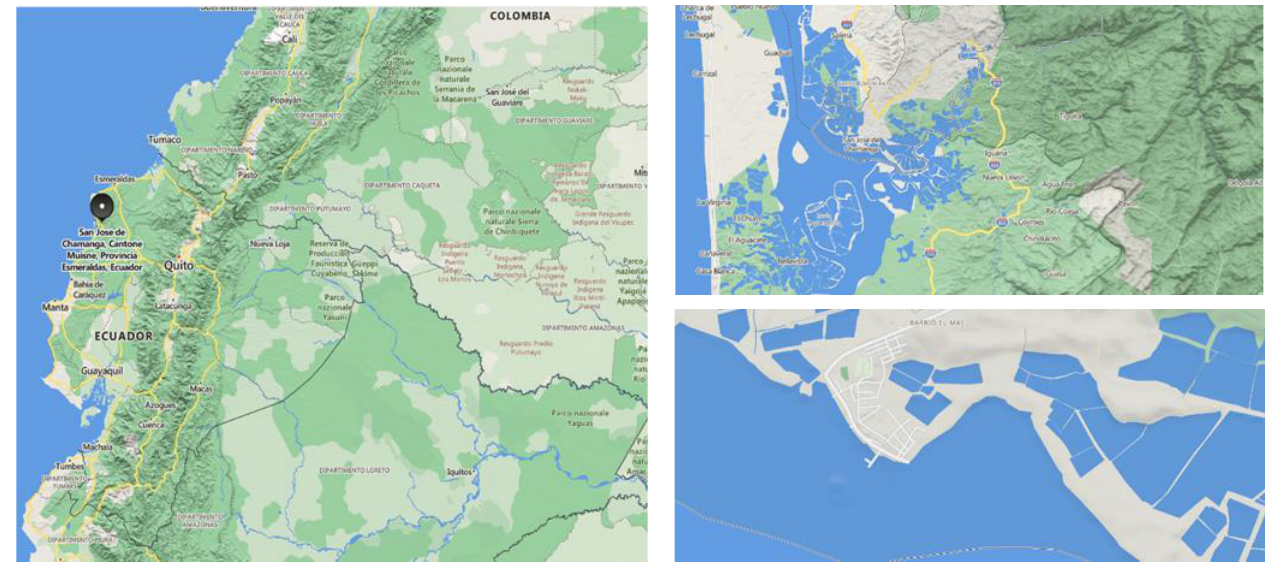
Figure 4. Three maps of San José de Chamanga at three different geographical scales (left: the position of the study site in Ecuador; upper right: the region of san José; upper left: the settlement and road network of the town of San José); redrawn and adapted from Google Maps imagery.